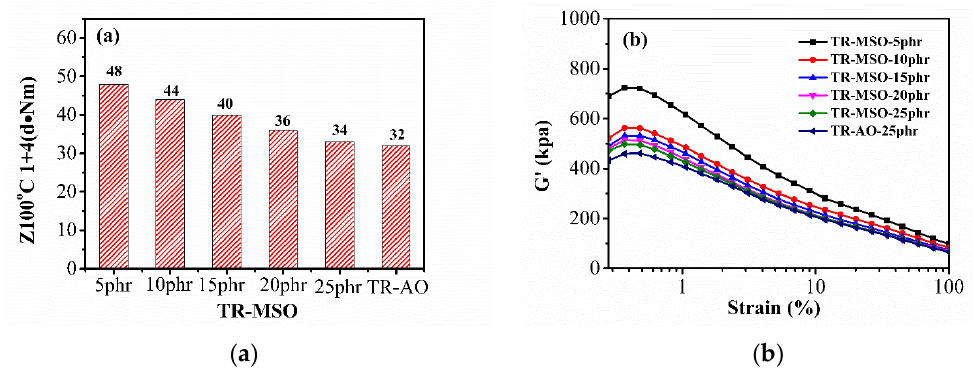
Figure 5. Mooney viscosity ( a ) and G ′ -strain curves ( b ) of tread rubber with different amounts of plasticizer.